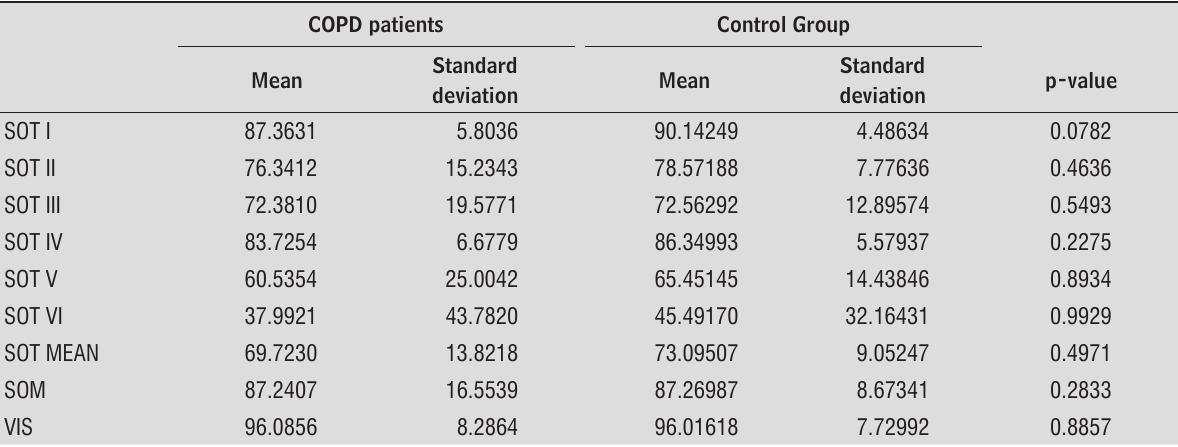
Table 2 - Descriptive measures and comparison of the values obtained in the Foam-Laser Dynamic Posturography tests performed by individuals with and without